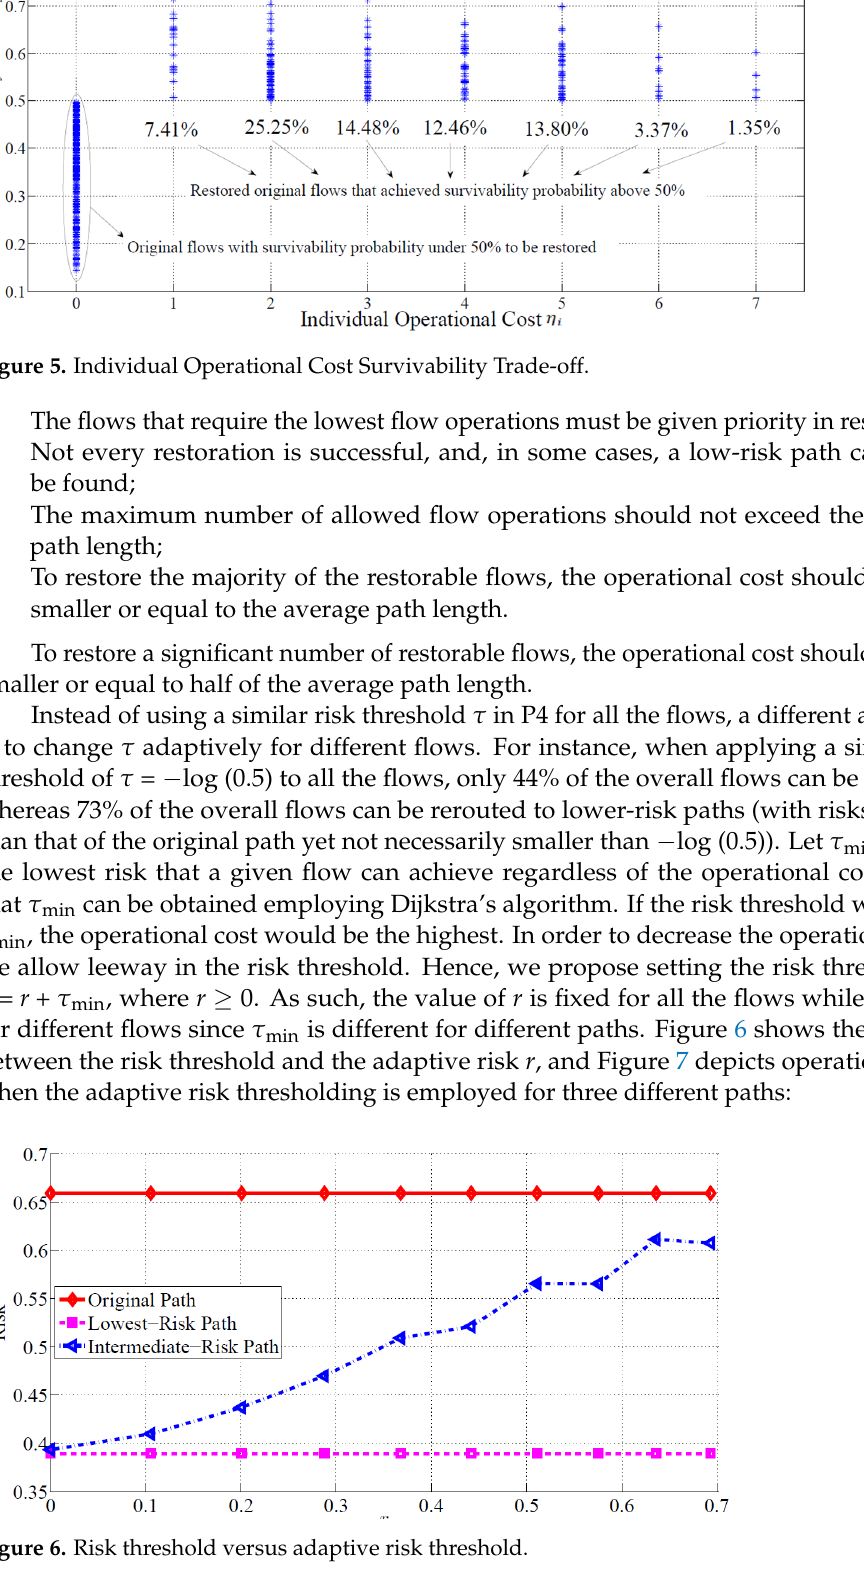
Figure 7. Average operation cost with adaptive risk threshold. 4. Suboptimal Algorithms In general, constrained shortest path problems are NP-Complete [31]. Thus, we need more efficient and less complex methods in order to solve these optimization problems. In this section, we propose a suboptimal method for the operational cost optimization problem (P4) and compare its performance with the well-known Lagrangian relaxation method [33]. 4.1. Iterative Risk Reduction (IRR) In this section, we introduce an algorithm that gradually decreases the risk of an ini- tial guess. The initial guess, in this case, is the original at-risk path that requires rerouting. It gradually modifies the initial guess by small corrections and discovers paths with lower risk. This algorithm is presented in Algorithm 1. The IRR algorithm first discovers paths with the lowest operational cost that does not traverse e ik,jk , where k ≥ 1 and equal to or smaller than the path length. Among the discovered paths, it then selects the one with the lowest possible risk. If necessary, it uses the operational cost as a tie-breaker. In other words, it iteratively finds a link whose removal from the network will render a path with a lower risk (compared to that of the path discovered at the previous iteration). In this fashion, the risk gradually decreases. We use three exit conditions in Algorithm 1, namely: